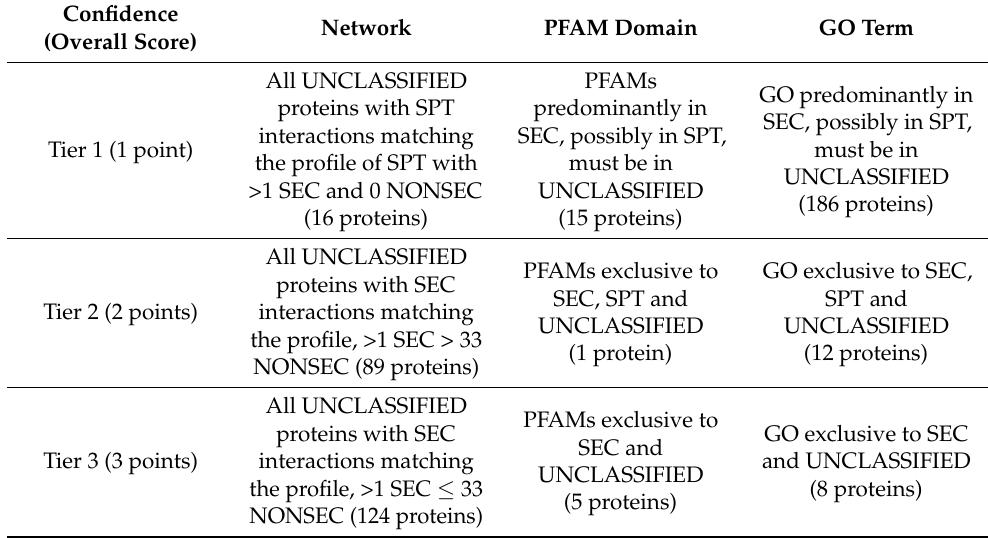
Table 1. LSPDB scoring criteria. Individual confidence criteria for each of protein–protein interaction network, PFAM domain, and GO term score for all LSPDB annotations. Overall confidence classifica- tion for proteins based on scoring ≥ 5 (High), 3 to 4 (Medium) or less than 3 (Low). An additional criterion of homodimers in the PPI network is classified as 0.5 points to note this category of interest, though this does not affect the scoring. Numbers in brackets correspond to the number of Arabidopsis proteins falling into each of the